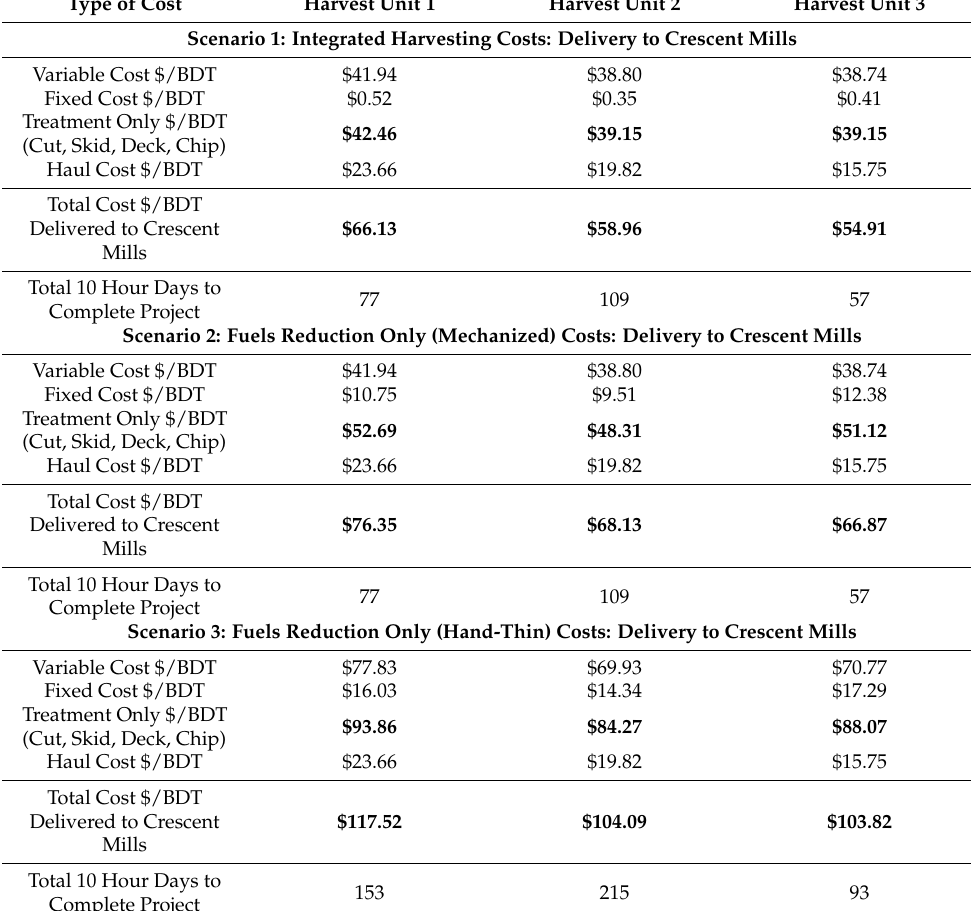
Table 7. Harvesting costs and other details under each